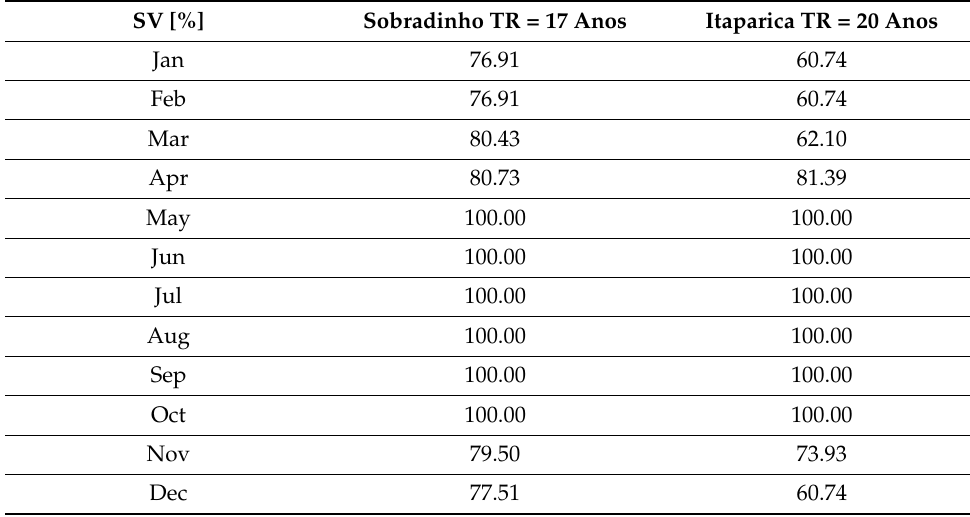
Table A1. Standby volume [39] RStorage ( n , m ) < SV